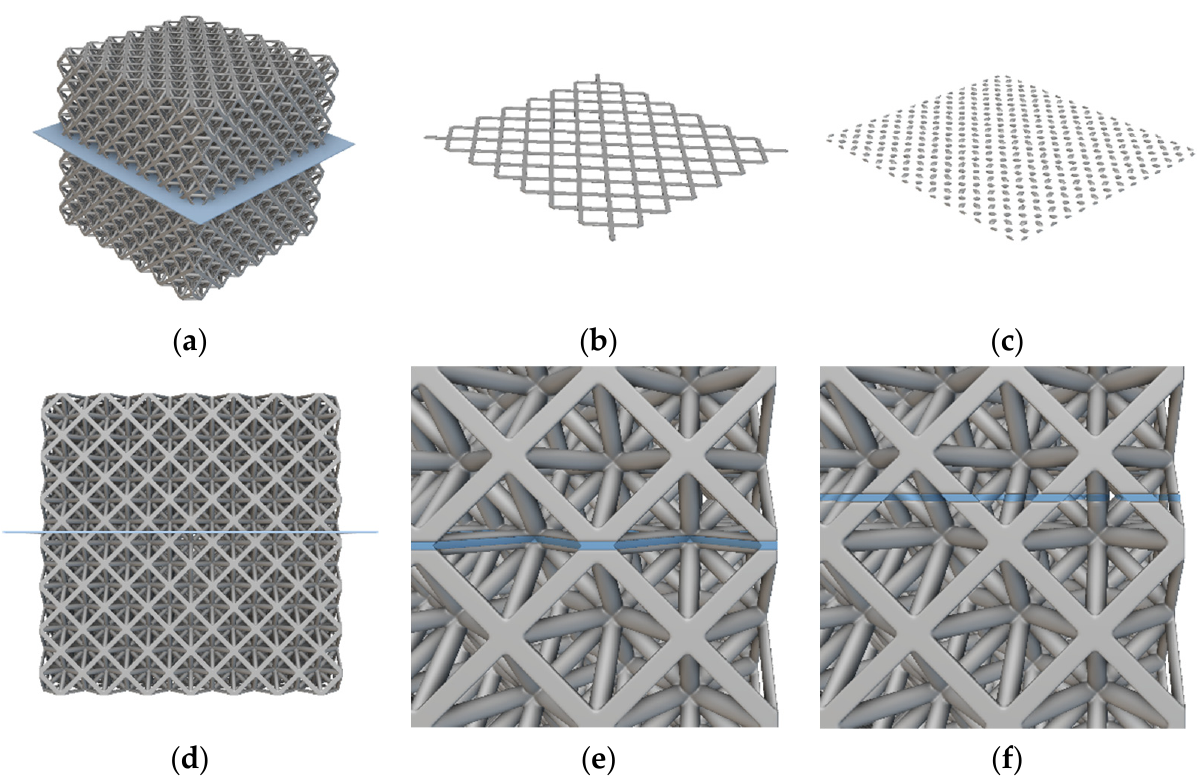
Figure 21. Cross-sectional slice images; ( a ) lattice block with slice plane, ( b ) cross-sectional slice at a height of z = 42 mm, ( c ) cross-sectional slice at a height of z = 42.3 mm, ( d ) front view of lattice block slice plane, ( e ) close-up view of slice volume (blue region) at z = 42 mm, ( f ) close-up view of slice volume (blue region) at z = 42.3 mm.